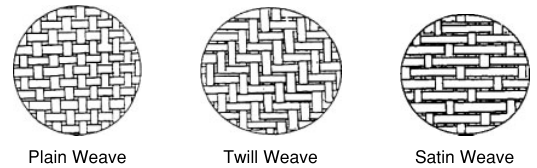
Figure 8 Three forms of textile weaving structures: (a) plain weave, (b) twill weave, (c) satin